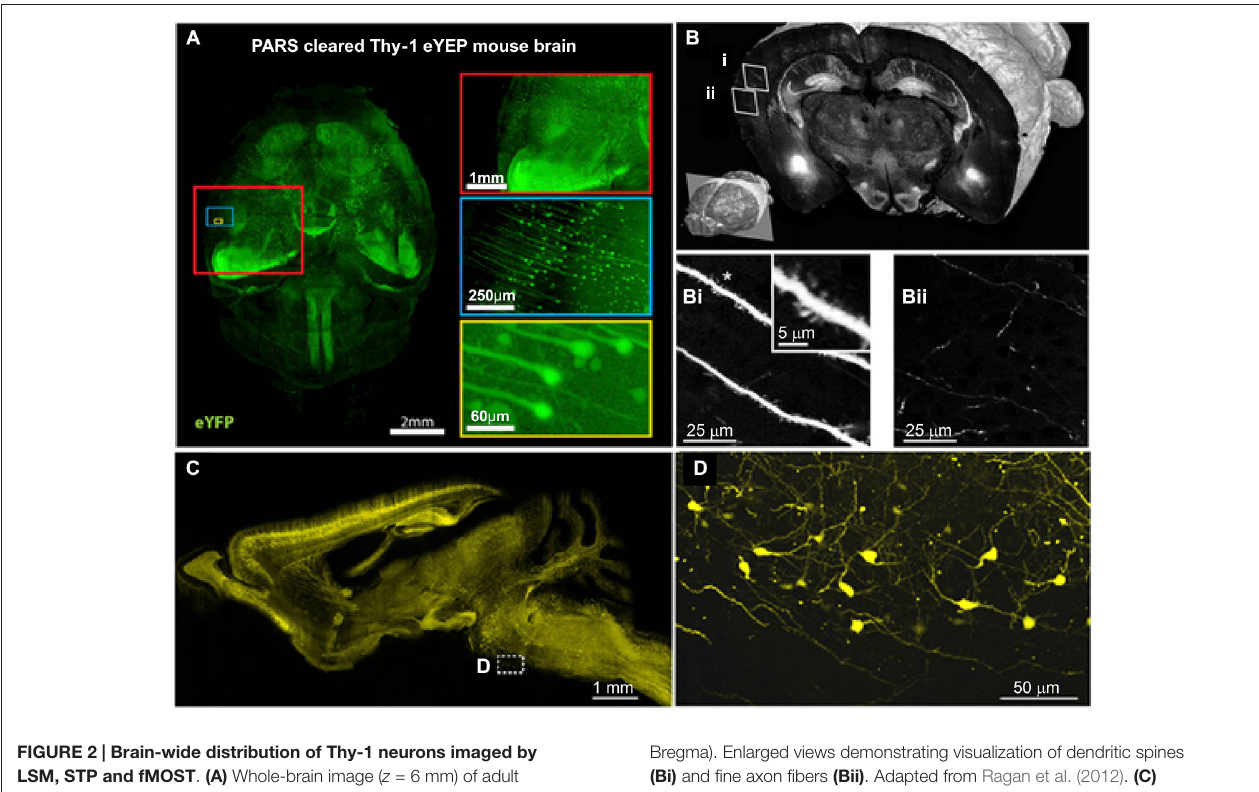
FIGURE 2 | Brain-wide distribution of Thy-1 neurons imaged by LSM, STP and fMOST . (A) Whole-brain image ( z = 6 mm) of adult Thy1-eYFP mouse after PARS clearing for 10 days. The boxes on the right show high-magnification images of indicated areas. PARS, perfusion-assisted agent release in situ . Taken from Yang et al. (2014). (B) 3D view of a coronal section of the GFP brain. Lower left: position of the coronal plane in the imaged mouse brain (approximately 2.5 mm from